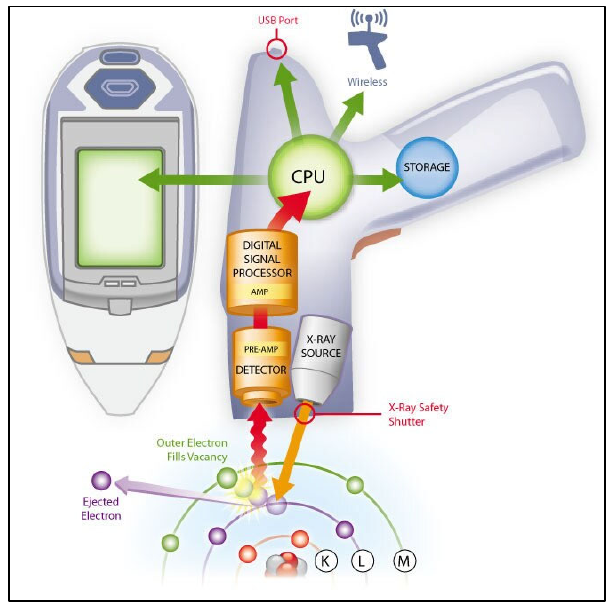
Figure 31. Components of a handheld XRF device for measuring the elemental composition [141].